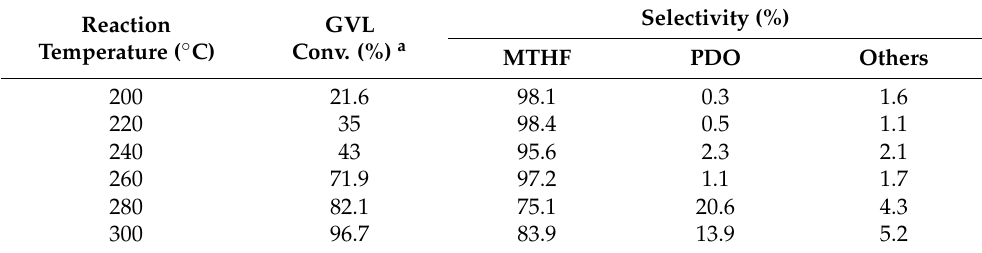
Table 7. Hydrogenation of GVL to 2-MTHF over 5% Cu/SiO 2 catalysts over various